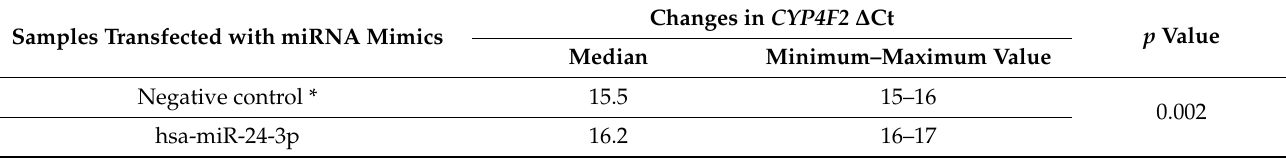
Table 5. Relative changes in the expression ( ∆ Ct) of CYP4F2 after transfection with hsa-miR-24-3p in HUVECs compared to negative control.